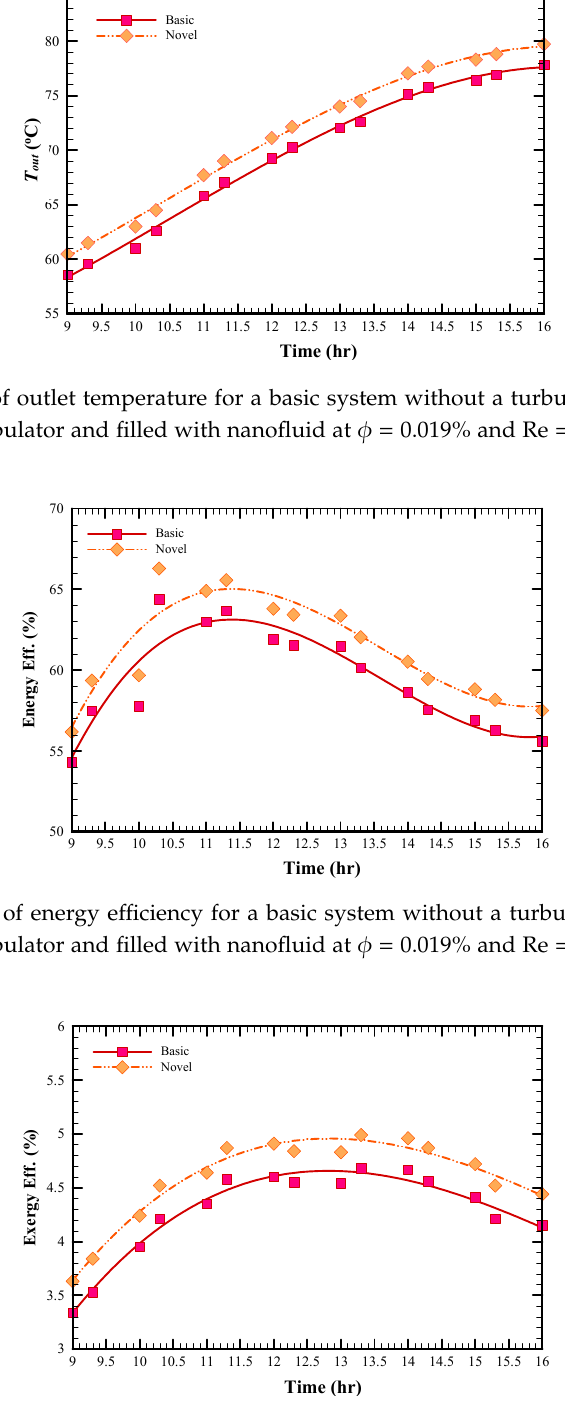
Figure 12. Variation of absorbed energy for a basic system without a turbulator and novel PTSC equipped with a turbulator and filled with nanofluid at ϕ = 0.019% and Re = 5000 versus different times of day. Figure 13 demonstrates the variation of average Nusselt number for a novel PTSC equipped with a turbulator and filled with nanofluid in different volume fractions of nanoparticles and Reynolds numbers at time 12:30. The average Nusselt number value is increased by the enhancement of Reynolds numbers in various volume fractions of nanoparticles. It also indicates that the novel solar collector with 0.075% volume concentration has the highest Nusselt number values among all studied models, which is followed by the volume concentrations of 0.050%, 0.040% and 0.019%, respectively.